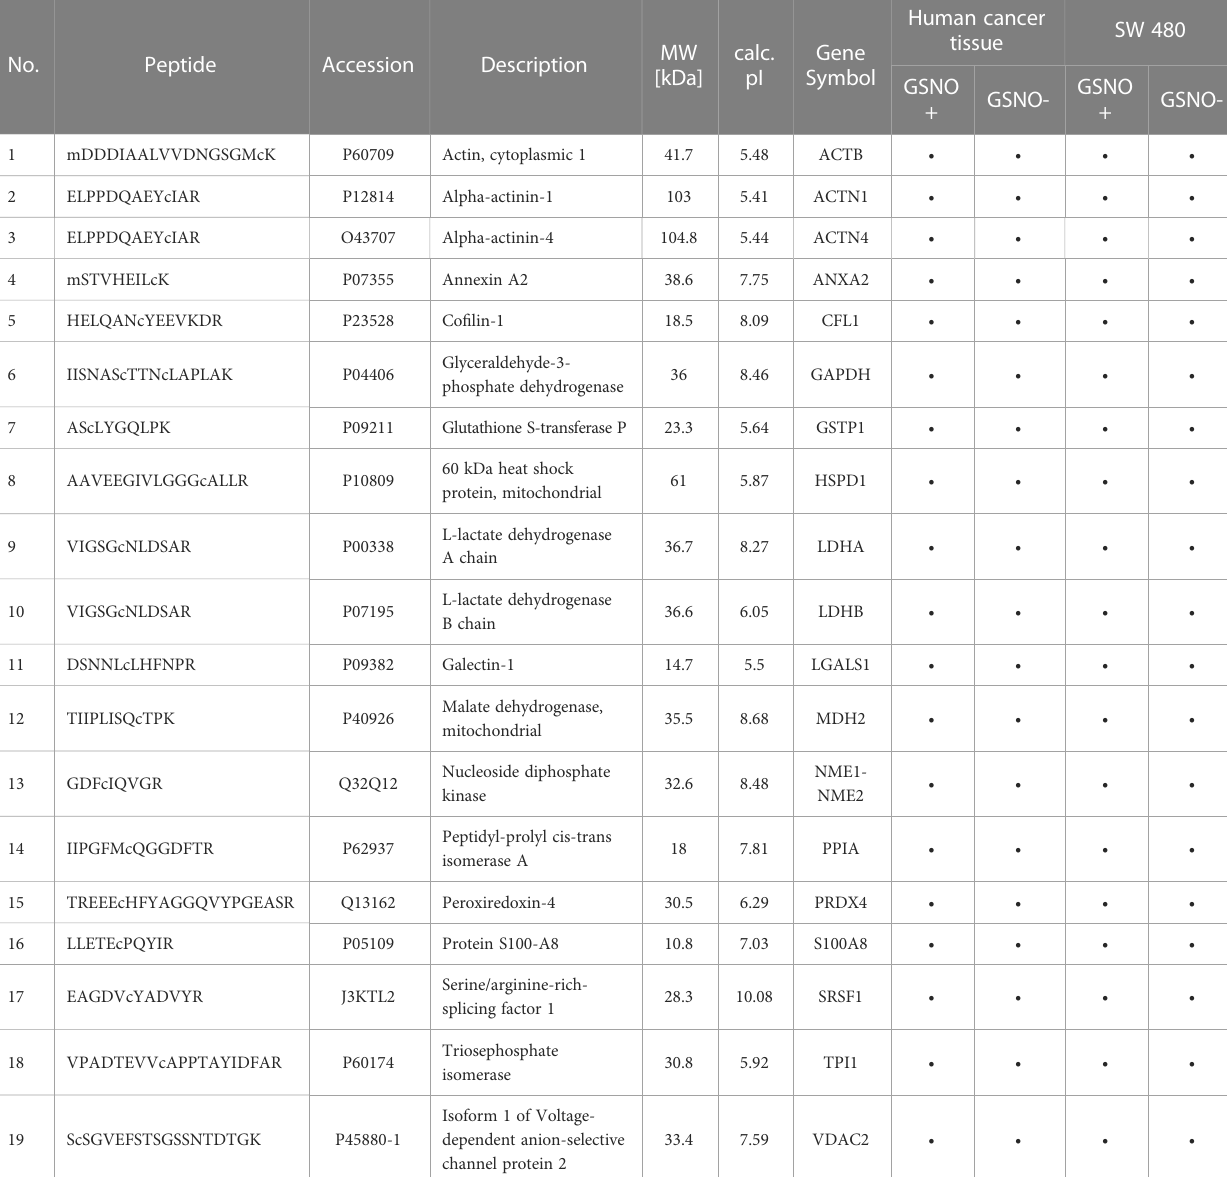
TABLE 1 List of 19 SNO proteins identi fi ed in both human cancer tissue and SW 480 cells.